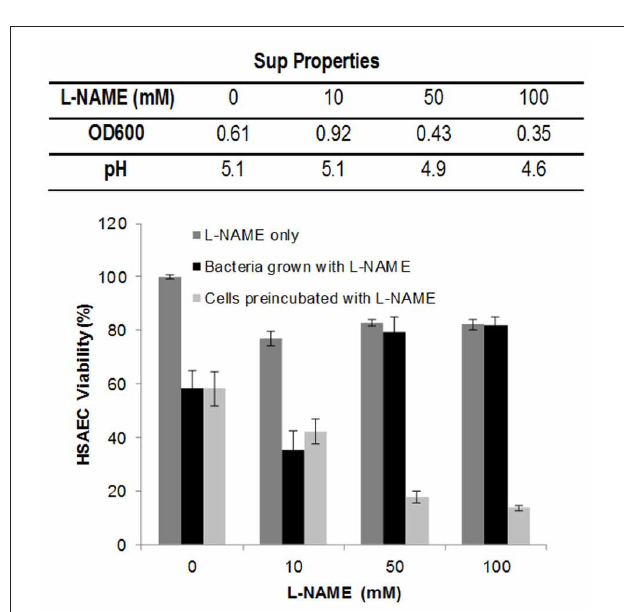
FIGURE 7 | Inhibition of baNOS with L-NAME decreases toxicity of Sups to HSAECs. Static cultures of dSterne strain were grown in complete DMEM/F12 as described in Materials and Methods with or without the indicated concentrations of L-NAME. The table shows the ODs and pHs of 24-hcultures. TheSupswere addedfor 2hto HSAECs pretreatedor notwith the indicated concentrations of L-NAME for 1h, and the viability of the cells was assayed with Alamar Blue. Controls included the culture medium with L-NAMEwithoutbacteria.All testedsamplesweretitratedwith HCltothepH 5.1 of Sups without L-NAME. Error bars indicate 95% confidence